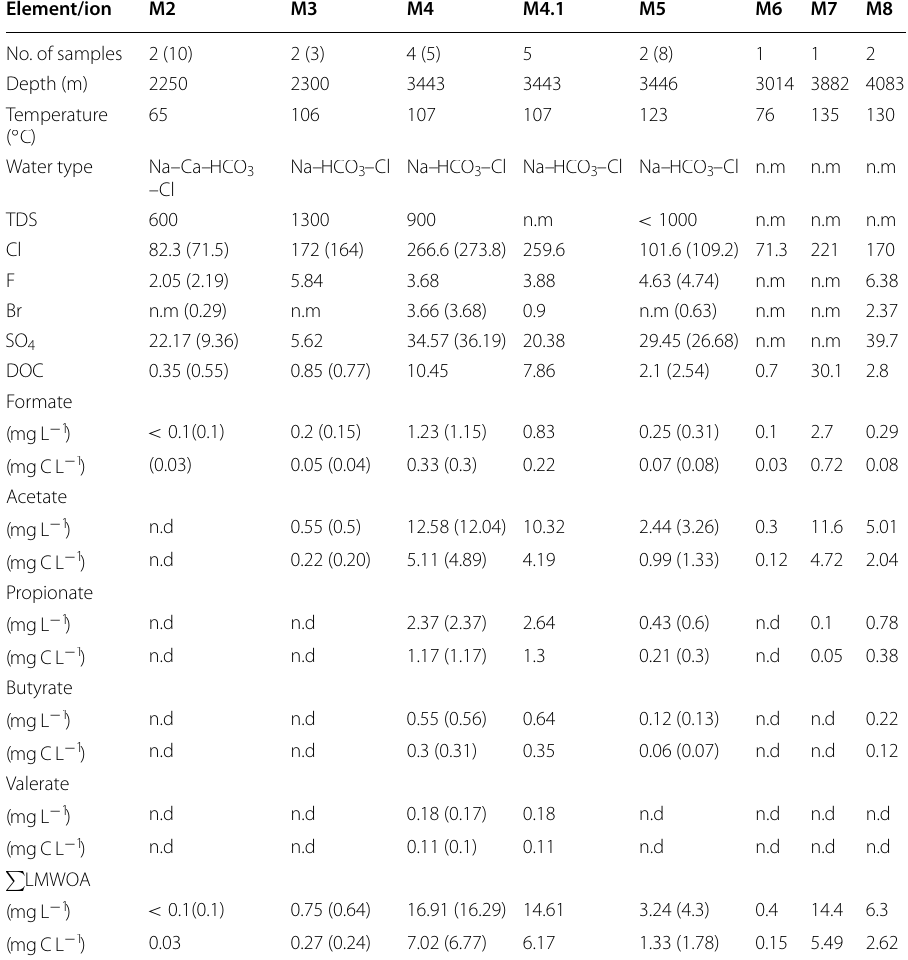
Table 5 Average organic and inorganic fluid chemistry of MB sites ( mgL − 1 and mgCL − 1 ), DOC ( mgCL − 1 ) from production side